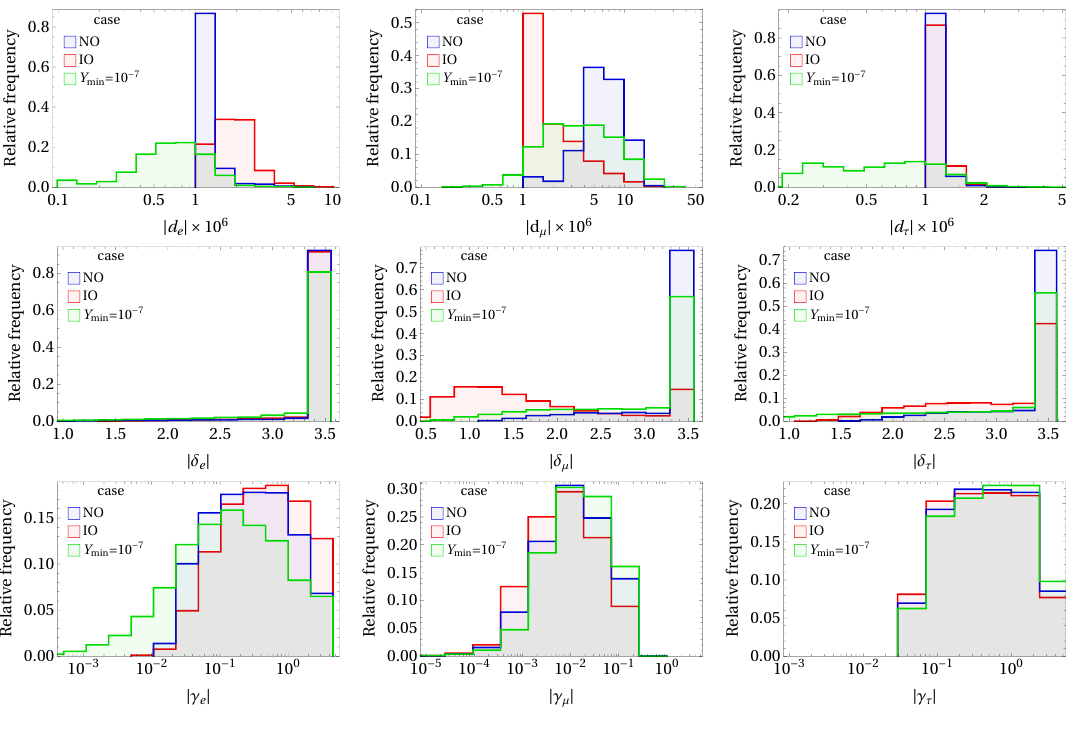
Figure 10 . The distributions of the moduli of the Yukawa couplings for the three fits.